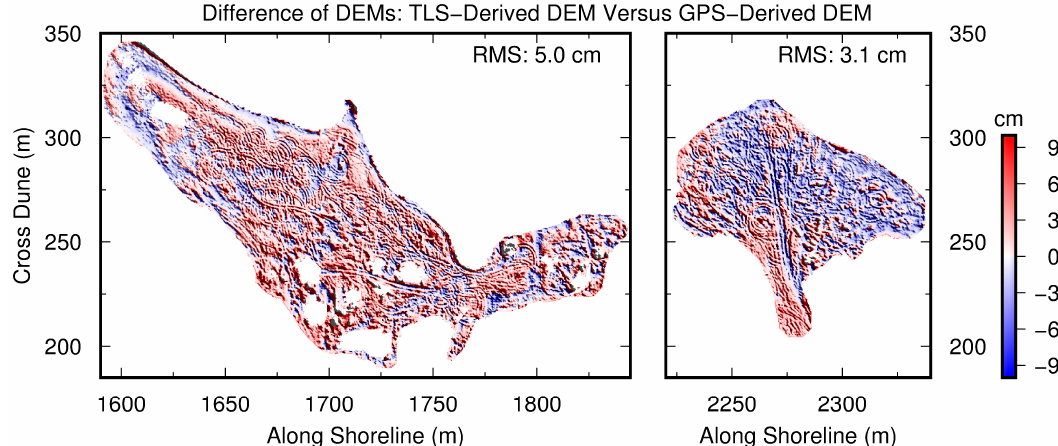
Figure 13. Map showing the difference between the TLS-derived digital elevation model (DEM) and